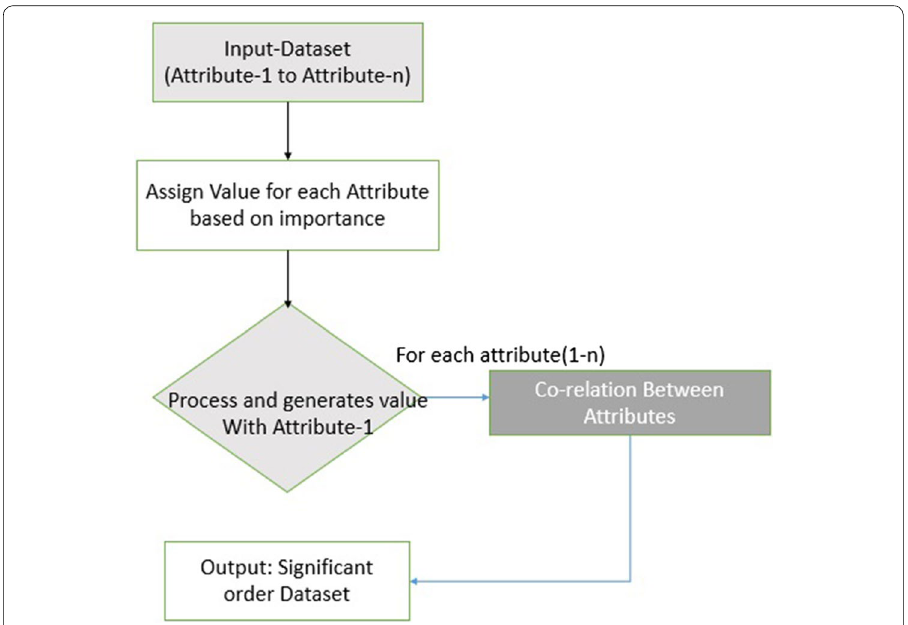
Fig. 6 Flow chart for attribute selection